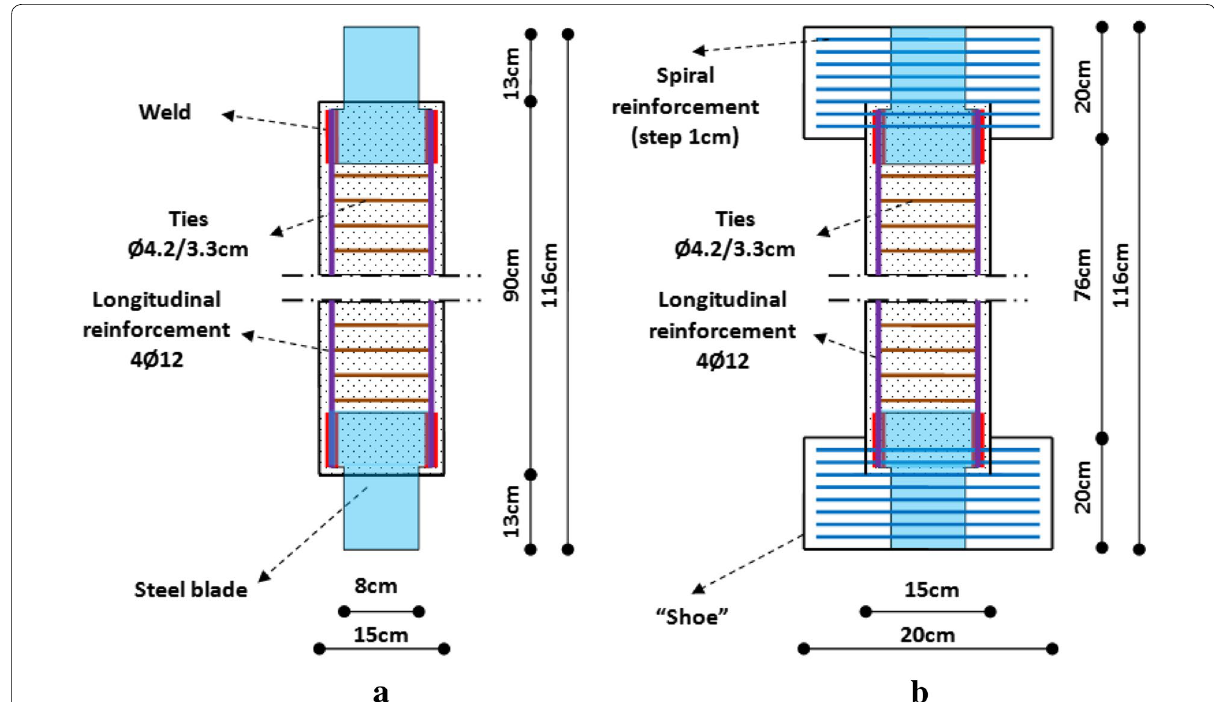
Fig. 1 Vertical reinforcement layout for: a tension test, b compression